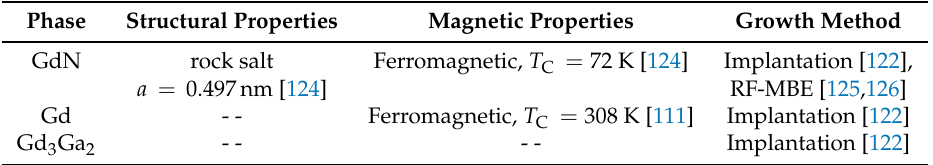
Table 4. Observed secondary- phases in Gd-doped GaN, their structural and magnetic properties, as well as the growth technique of the phase-separated